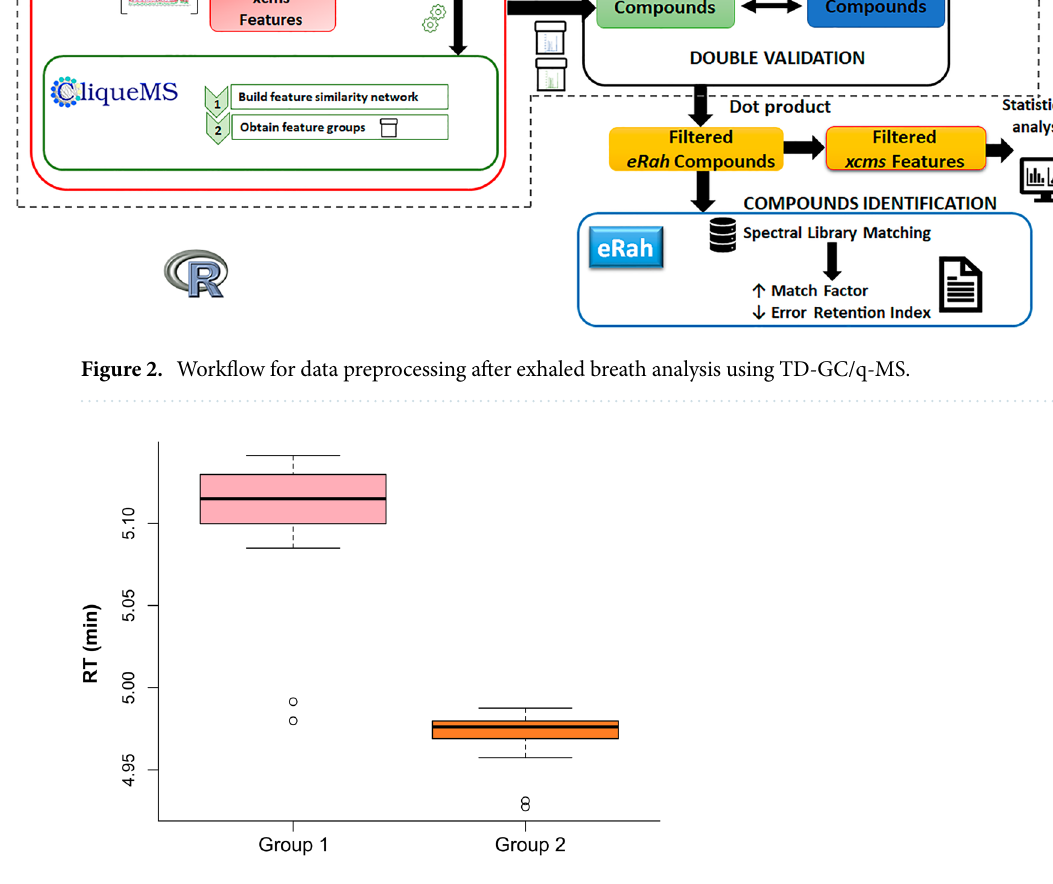
Figure 3. Differences in retention time between both sample groups. The graph shows the retention times of the 337 peaks detected in the room air content samples (210 in Group 1 samples) and (127 in Group 2 samples) at 91 m /z relative to toluene. Statistically significant differences between the retention times of both groups were observed using the two tailed Mann–Whitney U test ( p value =